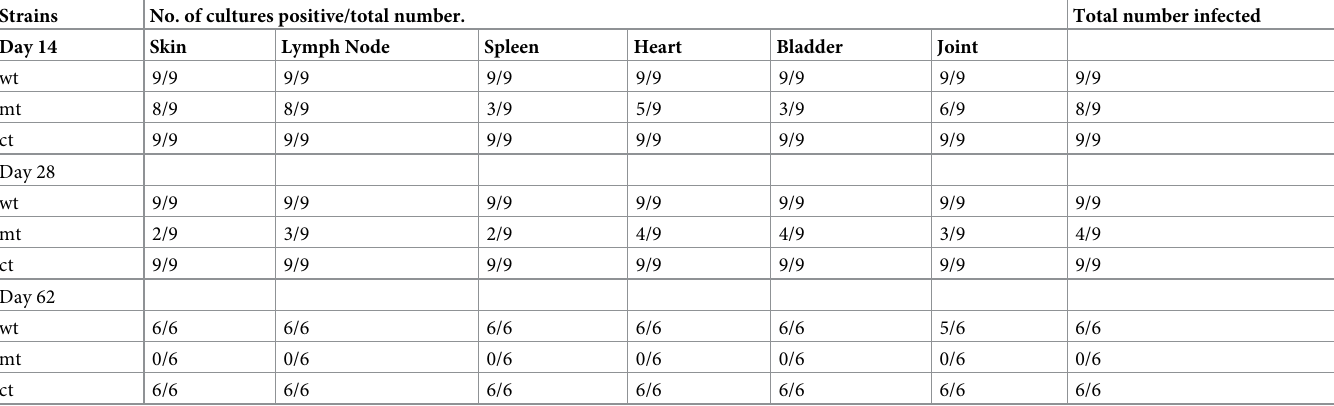
Table 1. Analysis of infectivity in C3H/HeN mice with wt, bpiP mt and bpiP ct strains at day 14, 28 and 62 post infection. Strains No. of cultures positive/total number.